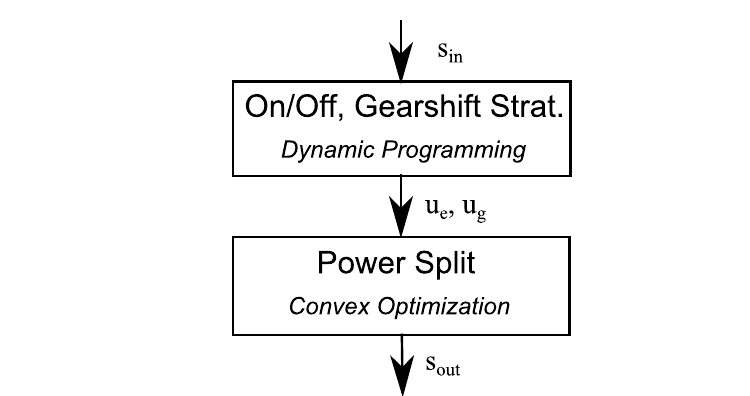
Figure 5. Sequential application of dynamic programming (DP) and convex